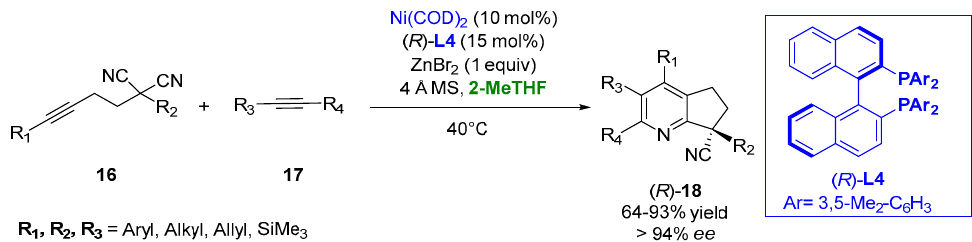
Figure 12. Chiral pyridine derivatives from functionalized malononitriles and alkynes.